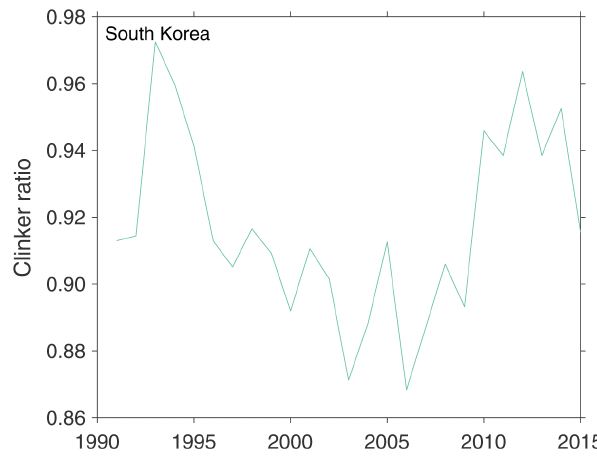
Figure C26. South Korea’s approximate clinker ratio, with no ac- count for clinker